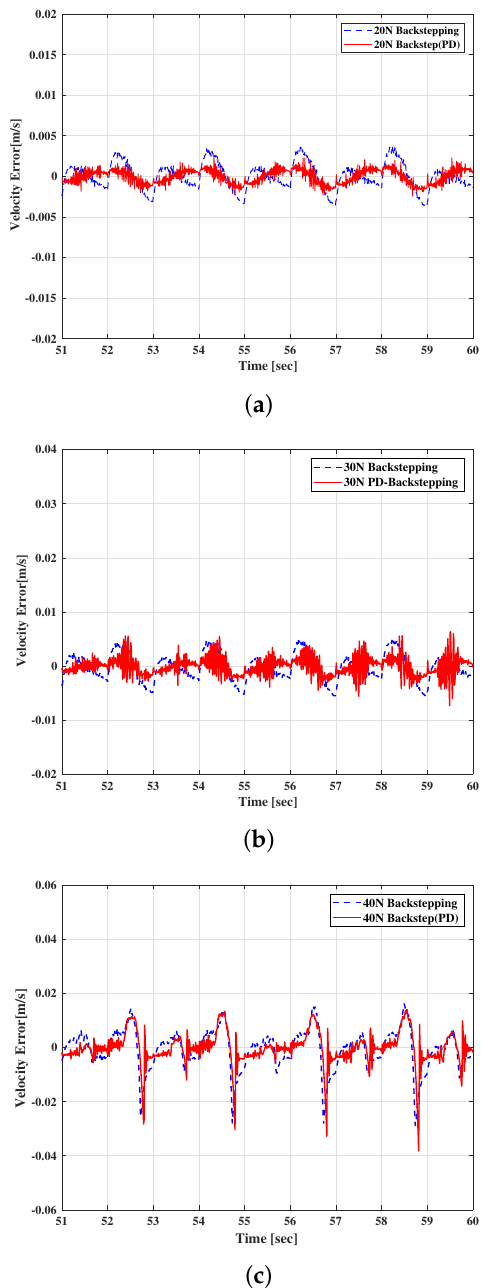
Figure 9. Velocity errors with variable brush interaction forces. ( a ) Force = 20 N; ( b ) Force = 30 N; ( c ) Force = 40